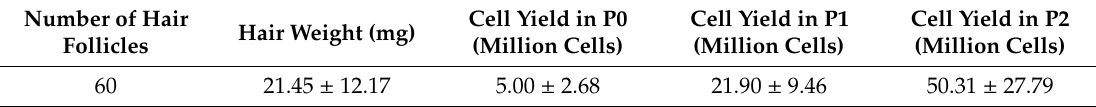
Table 1. Average MSCORS yield before